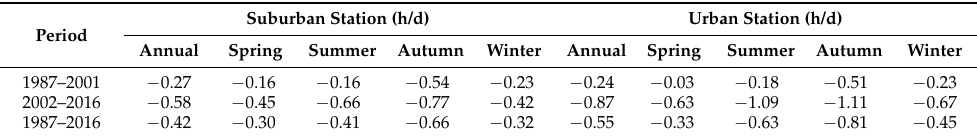
Table 3. Average effects of urbanization on the annual and seasonal mean sunshine duration ( SSD ) series at suburban and urban stations over different